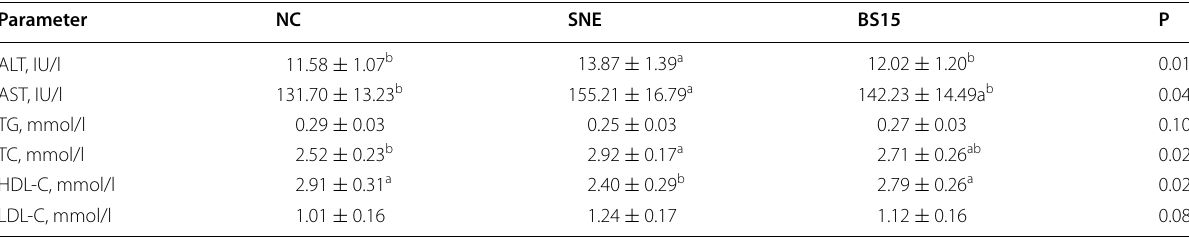
group and the control about above digestive enzymes. Table 5 Effects of Lactobacillus johnsonii BS15 on serum biochemical